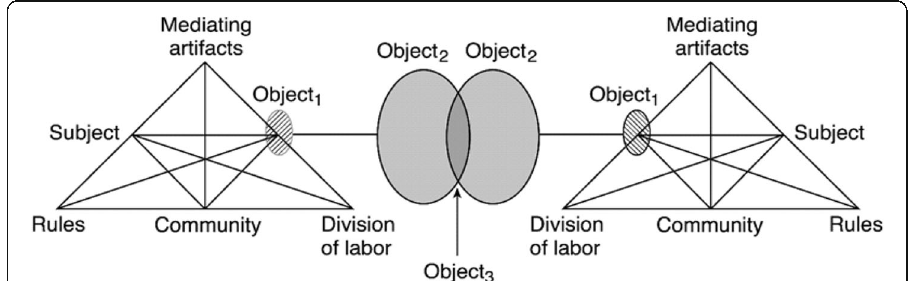
Fig. 4 Third-generation CHAT (Hardman,